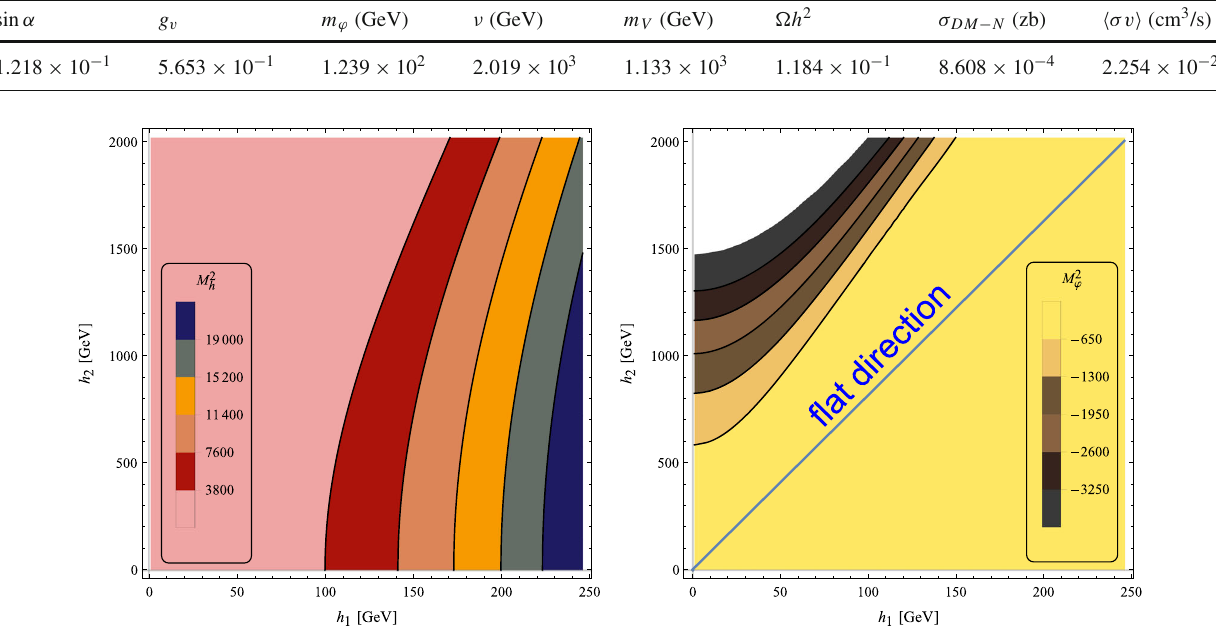
(left) is positive, while M 2 ϕ (right) is negative, except along the flat direction where M 2 ϕ = 0. In the h